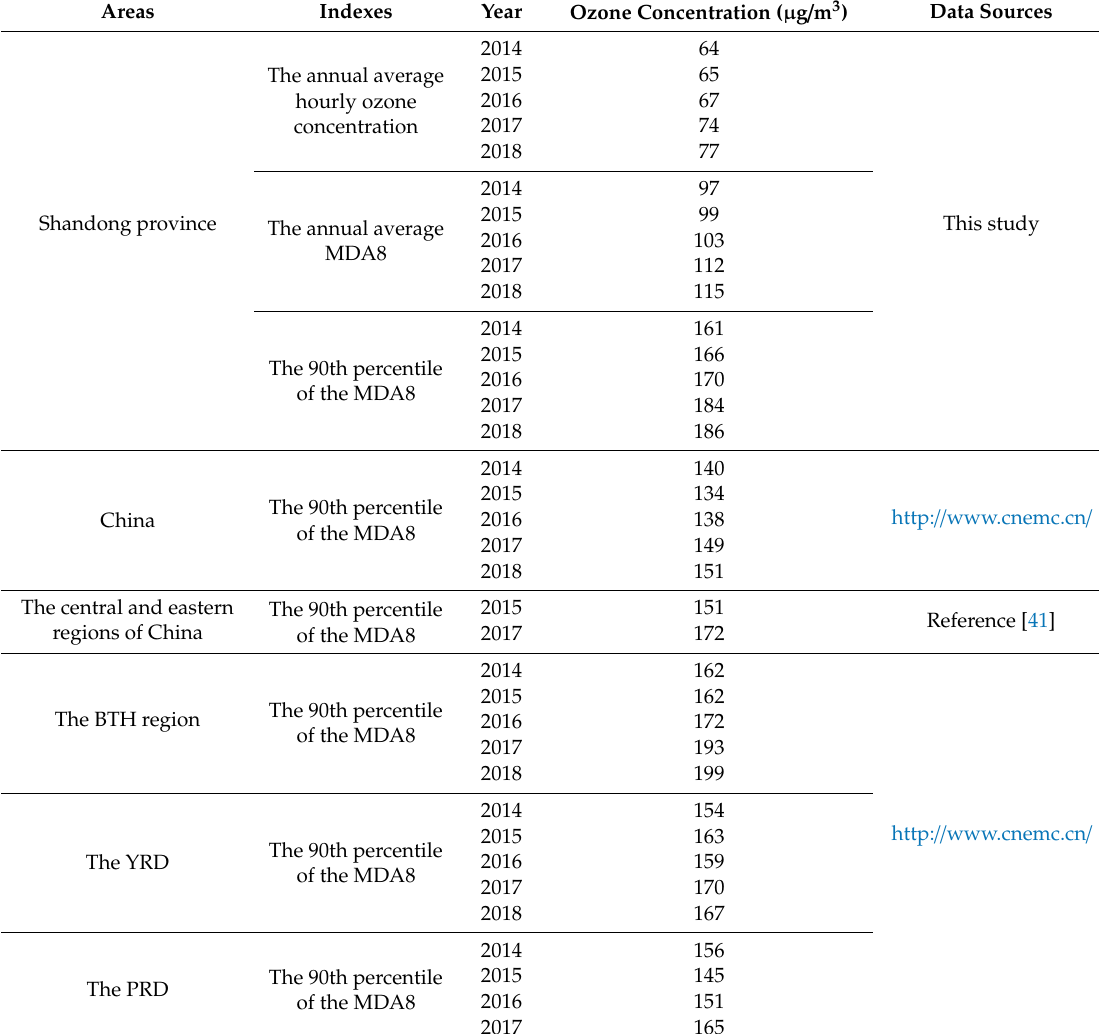
Table 1. Comparison of ground-level ozone concentration in several